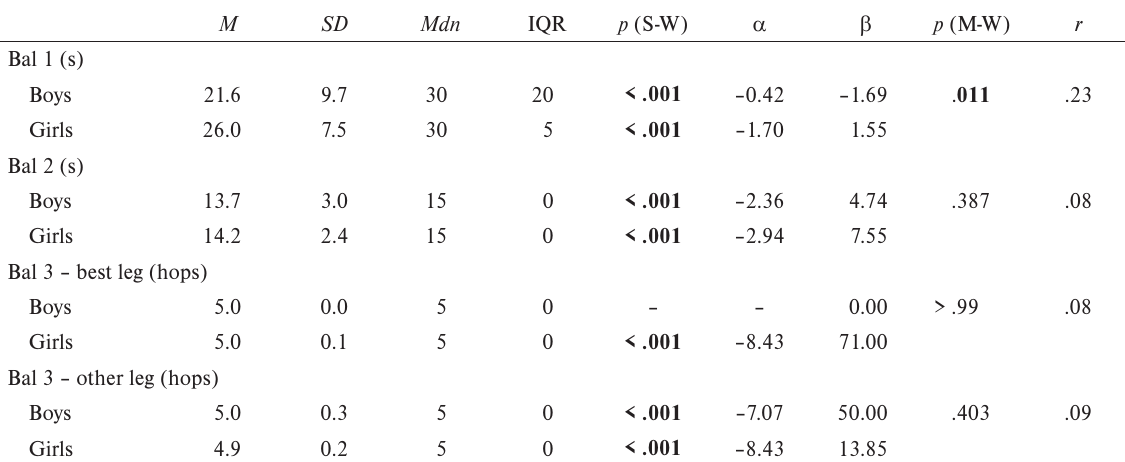
Descriptive characteristics of performance in the balance